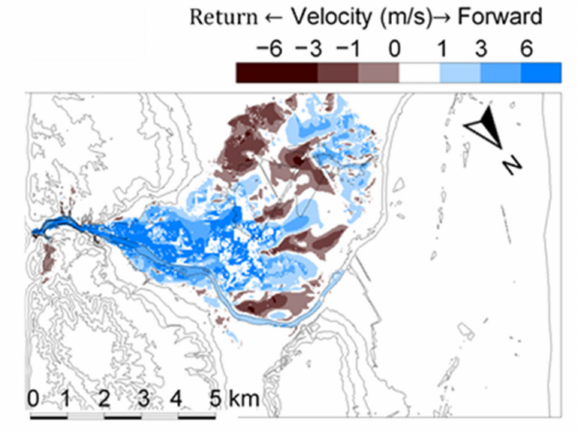
Figure 19. (Case–1). Inundation velocity 30 min after the start of the calculation.